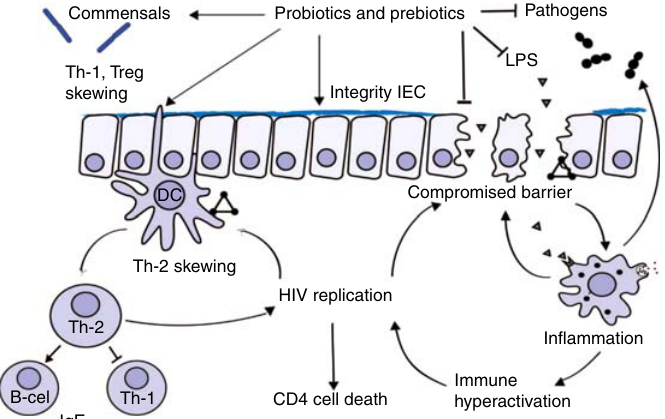
Figure 1. Potential benefits of probiotics and prebiotics in HIV-induced intestinal pathogenesis: HIV infection induces effects and positive feedback mechanisms that induce a loss of intestinal homeostasis and promotes the replication of the virus